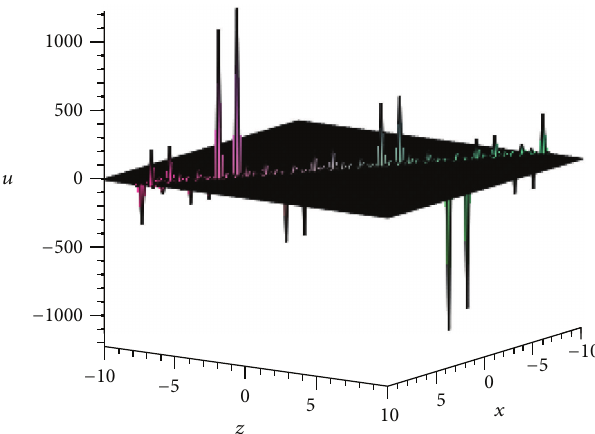
Figure 2: The shape of the 2-soliton to (1) with 𝜆 1 = −4 , 𝜆 2 = −1 , = 𝛾 = 0 . 𝑦 = 0 , 𝑡 = 0 , 𝛾 1 2